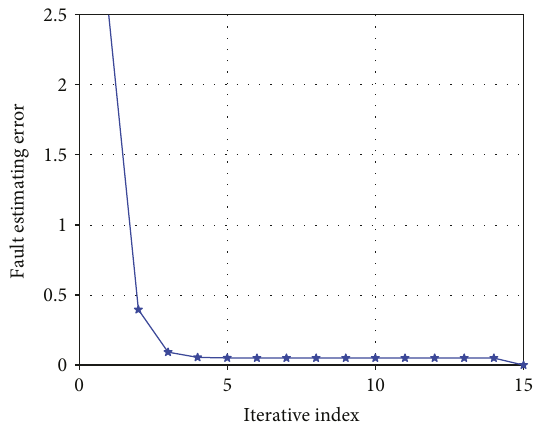
Figure 2: The tracking trajectory of slow variation fault for a nonlinear system with constant parameter uncertainties.